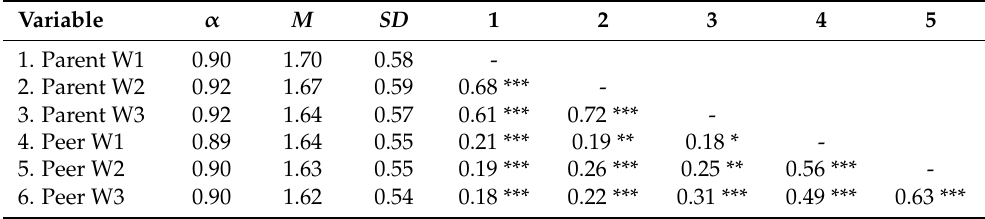
Table 1. Correlations among study